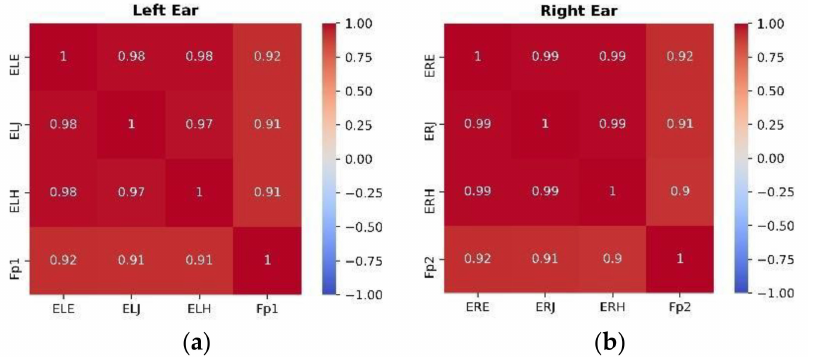
Figure 14. Pearson correlation coefficient matrix of in-ear and forehead locations for left ( a ) and right ear ( b